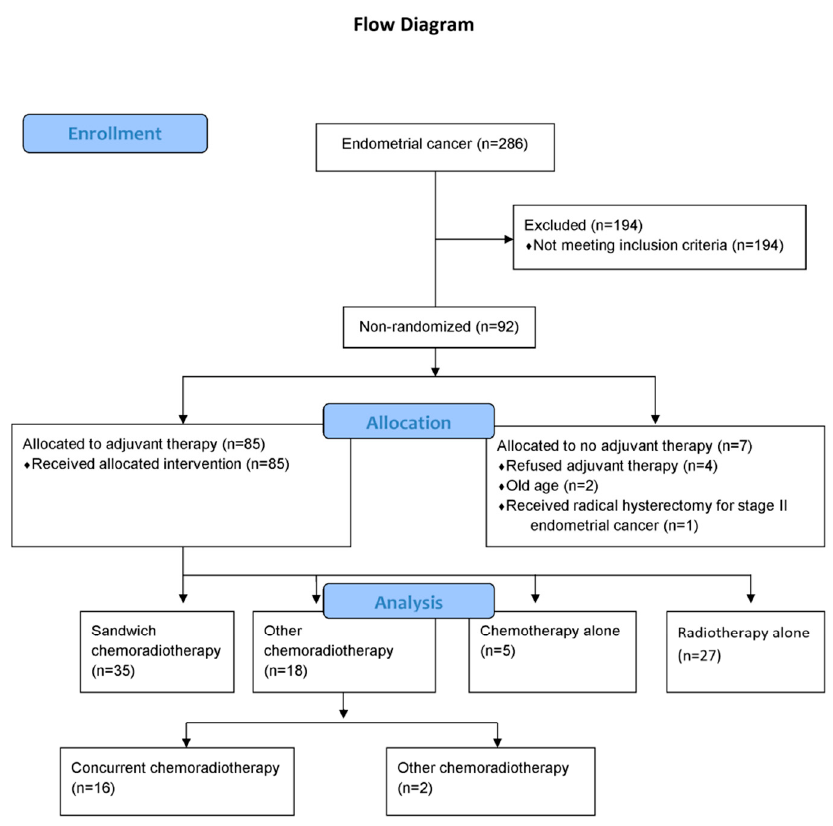
Figure 1. Patients with endometrial cancer. Table 1. Baseline data of high-risk endometrial cancer patients who underwent adjuvant therapy ( n =